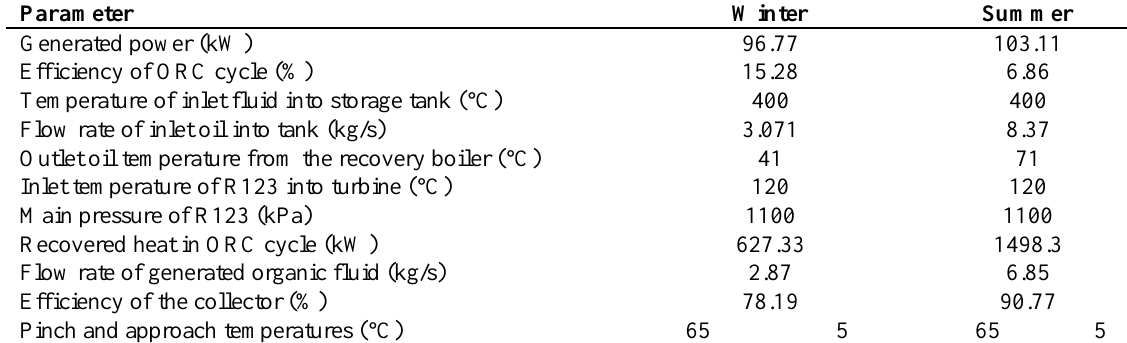
Table 5. Parameters of organic cycle along with solar field